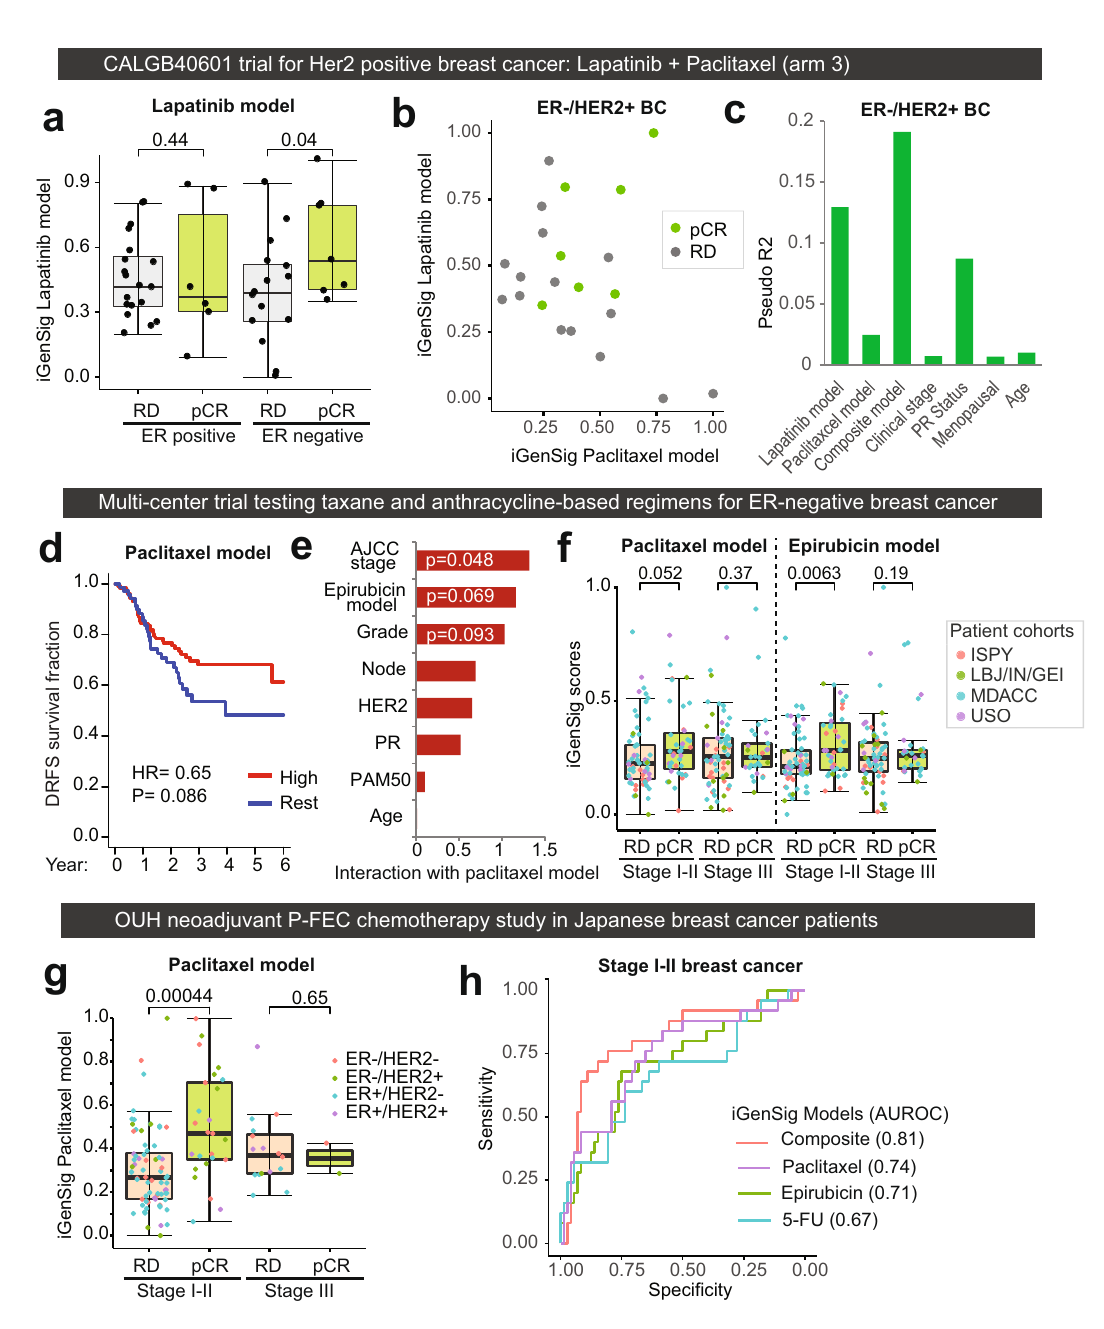
CALGB40601 trial for Her2 positive breast cancer: Lapatinib + Paclitaxel (arm 3)